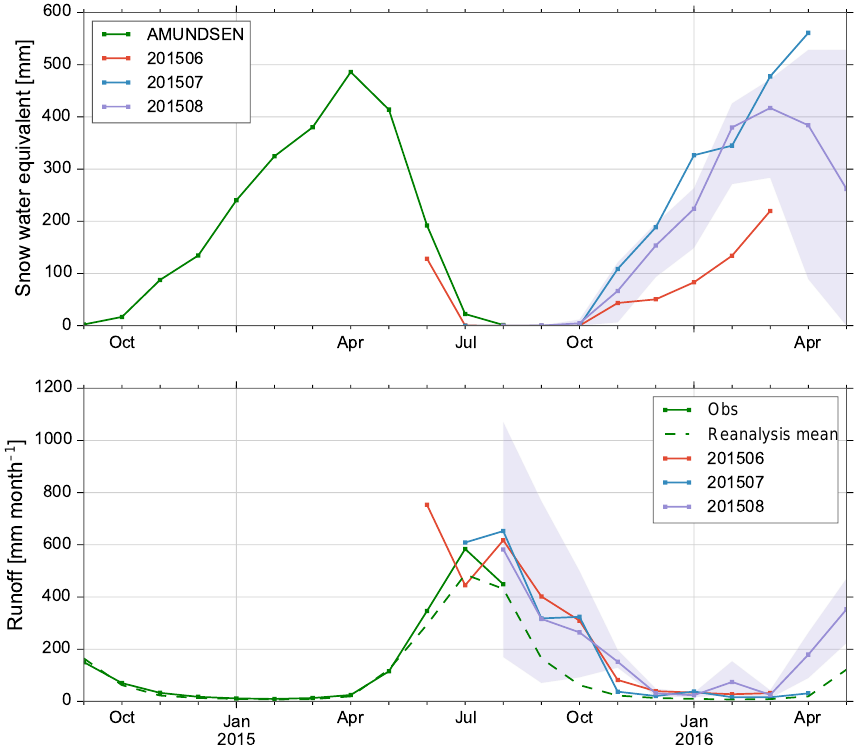
Figure 6. Seasonal forecasts of SWE (top) and runoff (bottom) using the water balance model AWARE, initialised by AMUNDSEN and forced by CFSv2. In addition to the ensemble mean, the range of results achieved by four CFSv2 runs in August 2015 is shown as shaded area. The dashed green line indicates average runoff conditions computed using re-analysis data